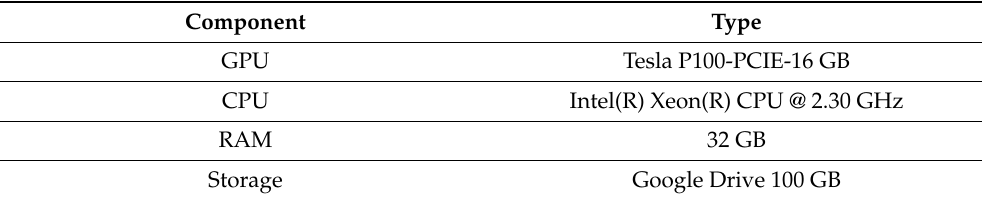
Table 5. Hardware.